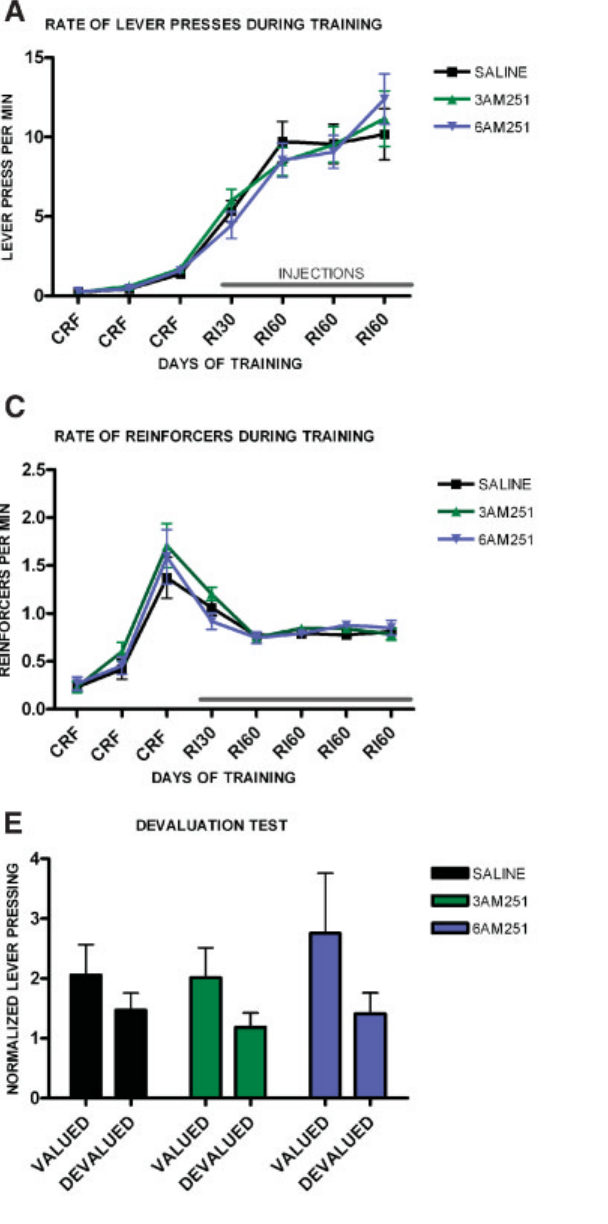
Figure 7. Decreased predisposition for habit formation in C57B16/J mice injected with CB1 antagonists during random interval training . ( A ) Acquisition of the lever-pressing task for animals injected with saline, 3 mg/kg AM251 or 6 mg/kg AM251. The rate of lever pressing (per minute) for each daily session is depicted. Note that animals were only injected during RI-30 and RI-60 training. ( B ) Average rate of head entry throughout training for mice injected with saline, 3 mg/kg AM251 or 6 mg/kg AM251. ( C ) Average rate of reinforcement throughout training for mice injected with saline, 3 mg/kg AM251 or 6 mg/kg AM251. ( D ) Rate of reinforcement per lever press throughout training for mice injected with saline, 3 mg/kg AM251 or 6 mg/kg AM251. ( E ) Normalized lever pressing during the valued versus the devalued condition for mice injected with saline, 3 mg/kg AM251 or 6 mg/kg AM251. The devaluation test was performed off